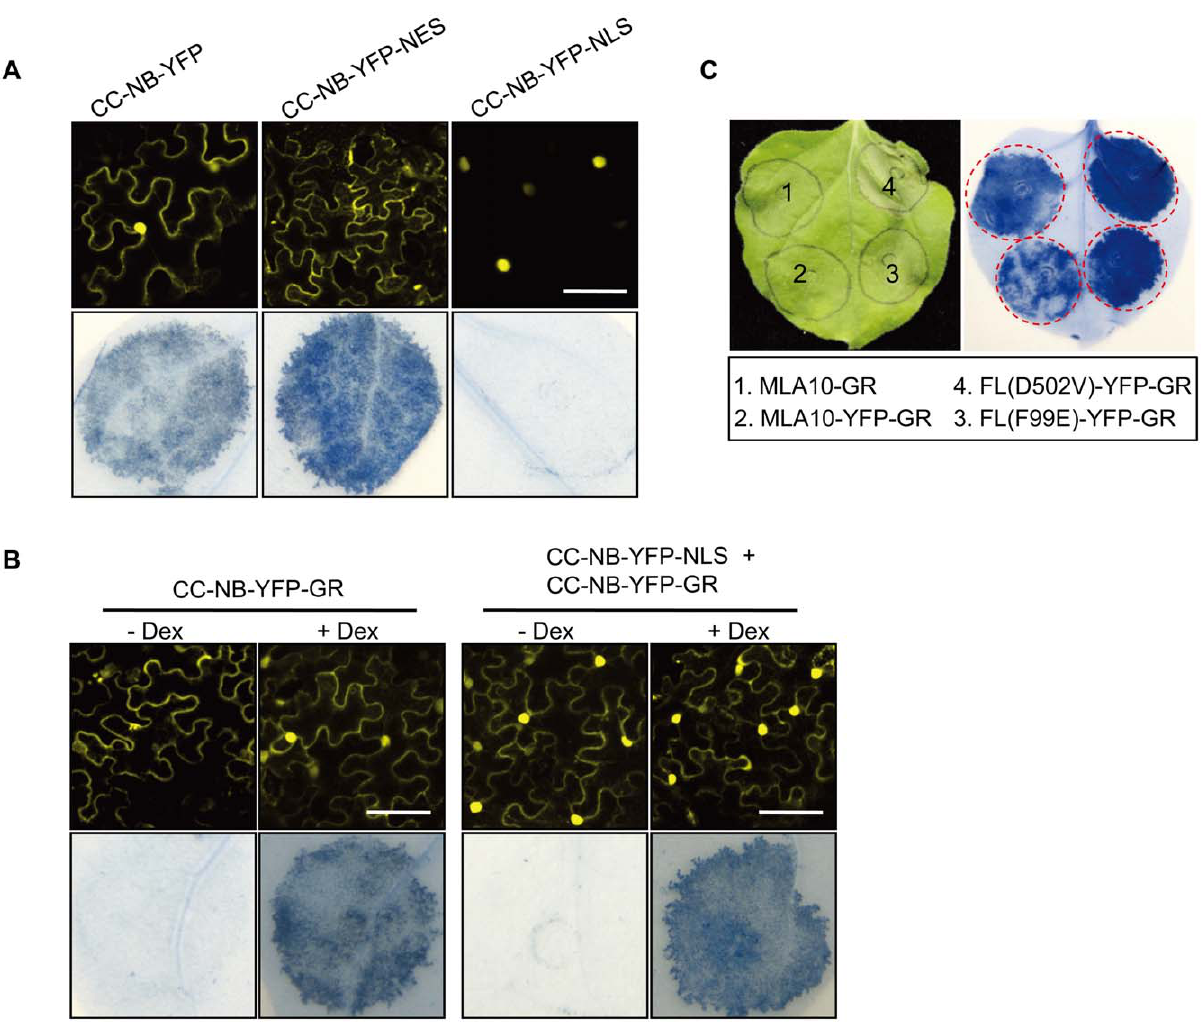
Figure 6. MLA10 CC-NB or full-length trigger cell death signaling in the cytoplasm. ( A ) Analysis of cell death inducing activity of MLA10 CC-NB fusion proteins. MLA10 CC-NB fusion proteins, CC-NB-YFP, CC-NB-YFP-NES and CC-NB-YFP-NLS, were expressed in N. benthamiana leaves by Agro-infiltration; confocal images were taken at , 22 hpi (upper panel) and cell-death triggered by each fusion protein was scored by trypan blue staining at , 48 hpi (lower panel). Scale bar is 50 m m. ( B ) Analysis of cell death phenotype upon expression of MLA10 CC-NB-YFP-GR or co-expression of MLA10 CC-NB-YFP-NLS and CC-NB-YFP-GR fusions before and after Dex treatment. The indicated fusion(s) were expressed in N. benthamiana leaves by Agro-infiltration. Buffer with/or without Dex was sprayed onto N. benthamiana leafs 20 hpi before the confocal images were taken (upper panel). The cell-death phenotype of each fusion protein was scored by trypan blue staining at , 48 hrs post treatment with/or without Dex (lower panel). GR: Steroid binding domain of the mammalian glucocorticoid receptor. Scale bar is 50 m m. ( C ) Analysis of cell death activity of GR fusions of MLA10 WT and autoactive variants. Indicated MLA10-GR fusion, and the C-terminal YFP-GR fusions of MLA10 WT and two autoactive mutant variants were expressed in N. benthamiana leaves by Agro-infiltration. The cell-death phenotype was revealed by trypan blue staining at , 24 hrs post infiltration without Dex induction.